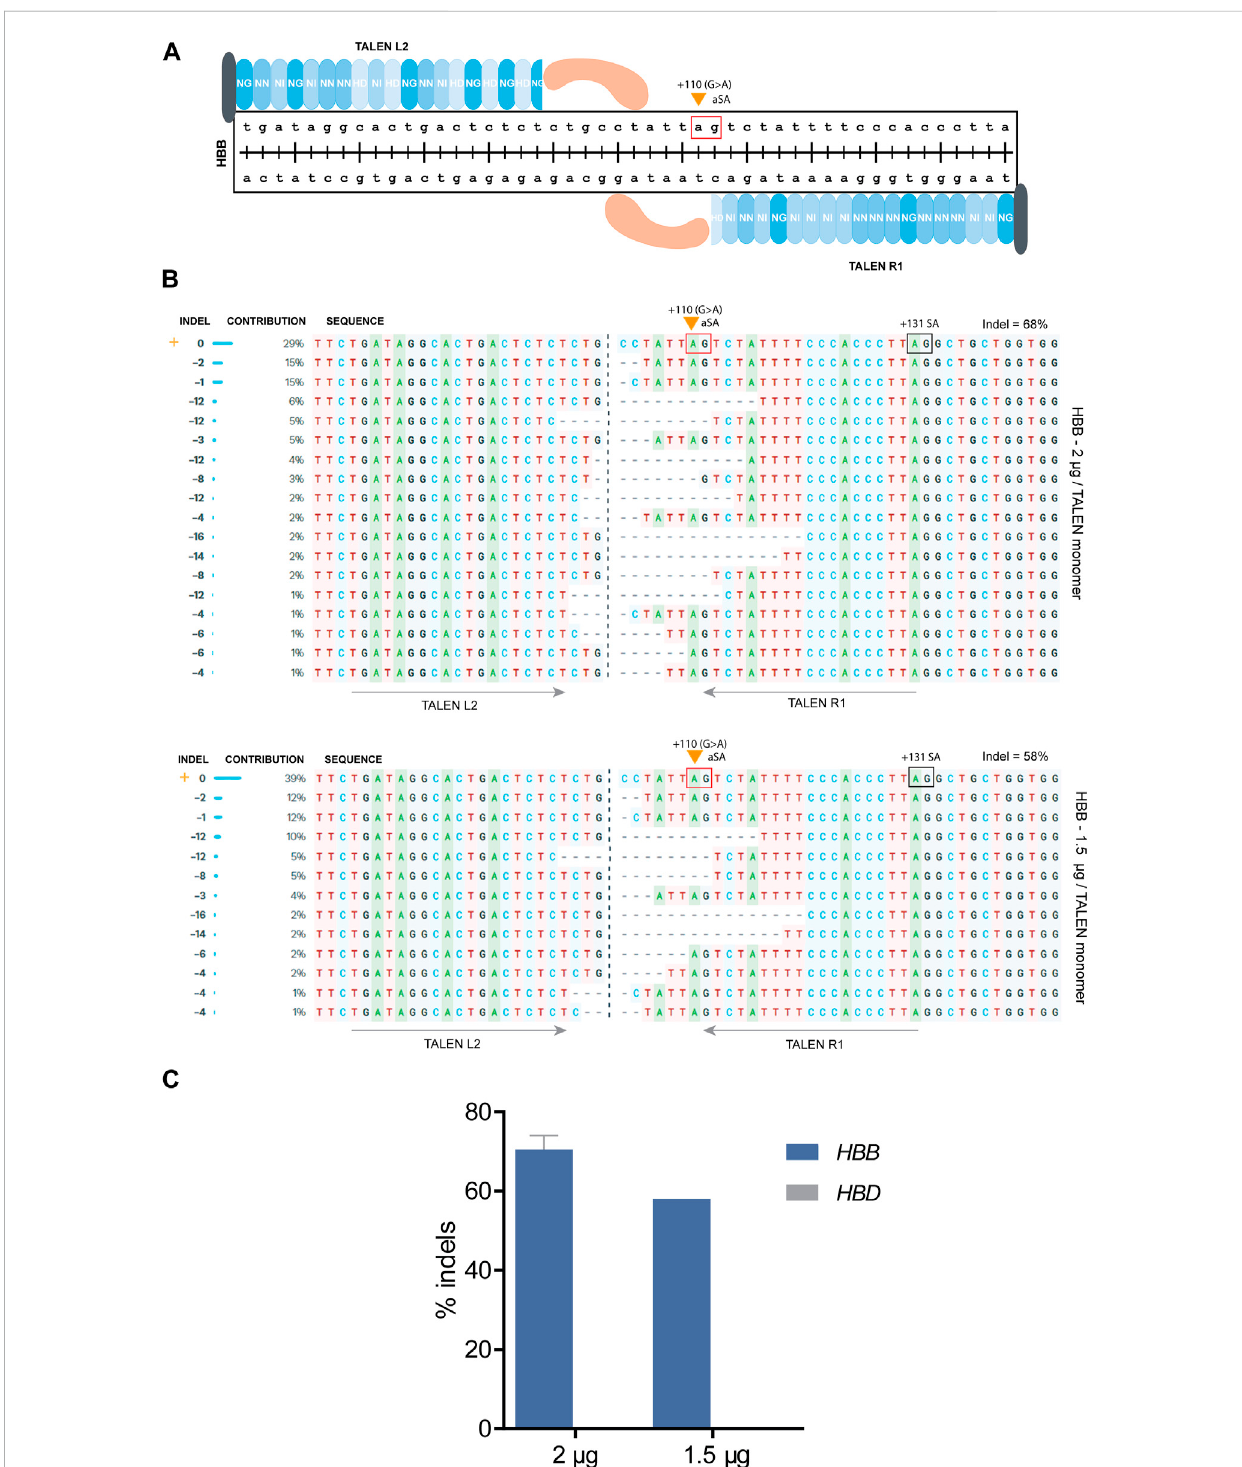
FIGURE 4 TALEN-based targeting of the HBB IVSI − 110(G > A) mutation in patient-derived CD34 + cells. (A) A schematic diagram showing the design of TALENs targetingthe HBB IVSI − 110(G > A) mutation(orangearrow).TheredboxshowstheaSA(AGdinucleotide)thatiscreatedbythemutation.TheTALENmonomers L2 and R1 were used to introduce DSBs and create indels upstream of the splice acceptor site. The blue shaded repeated shapes represent the speci fi c RVDs used for the design, the black shape shows the N-terminus, while the orange shape represents the Fok1 endonuclease monomer. (B) Alignment of the various editing events resulting from the disruption of the upstream splice acceptor site using the TALENs R1/L2 pair. For the top alignment 2 μ g , for the bottom 1.5 μ g were used per TALEN monomer. The INDEL column shows the exact number of deleted ( < 0) nucleotides, the CONTRIBUTIONcolumnthepercentage of these indelsinthebulkpopulation , and theSEQUENCEcolumn theeditedsequences containing thevarious indels aligned with the wild type (orange cross). The orange arrow indicates the HBB IVSI − 110(G > A) mutation as the fi rst base of the aSA (red box); the